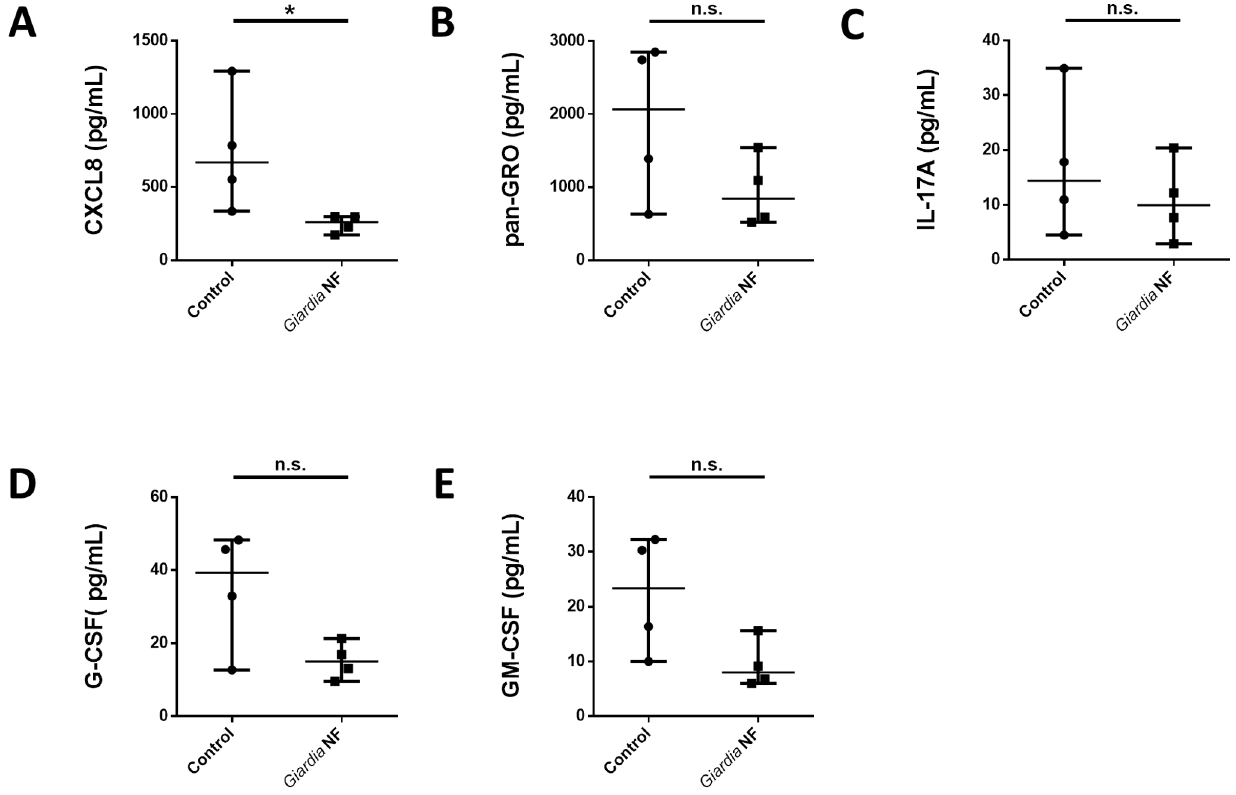
Figure 7. Giardia NF trophozoites attenuate the expression of IL-8/CXCL8 assessed in colonic mucosal biopsy homogenates. Human descending colon mucosal biopsy tissues obtained from areas of active inflammation from patients with active Crohn’s disease (CD) were incubated with 5.0 6 10 6 Giardia NF trophozoites for 6 hours. Tissue homogenate levels of (A) CXCL8, (B) GRO, (C) CCL3, (D) IL-17A, (E) G-CSF, and (F) GM-CSF were determined via a bead-based cytokine assay. All data are representative of three independent experiments (n=4–6/group) and represented as median with the range. * p , 0.05.